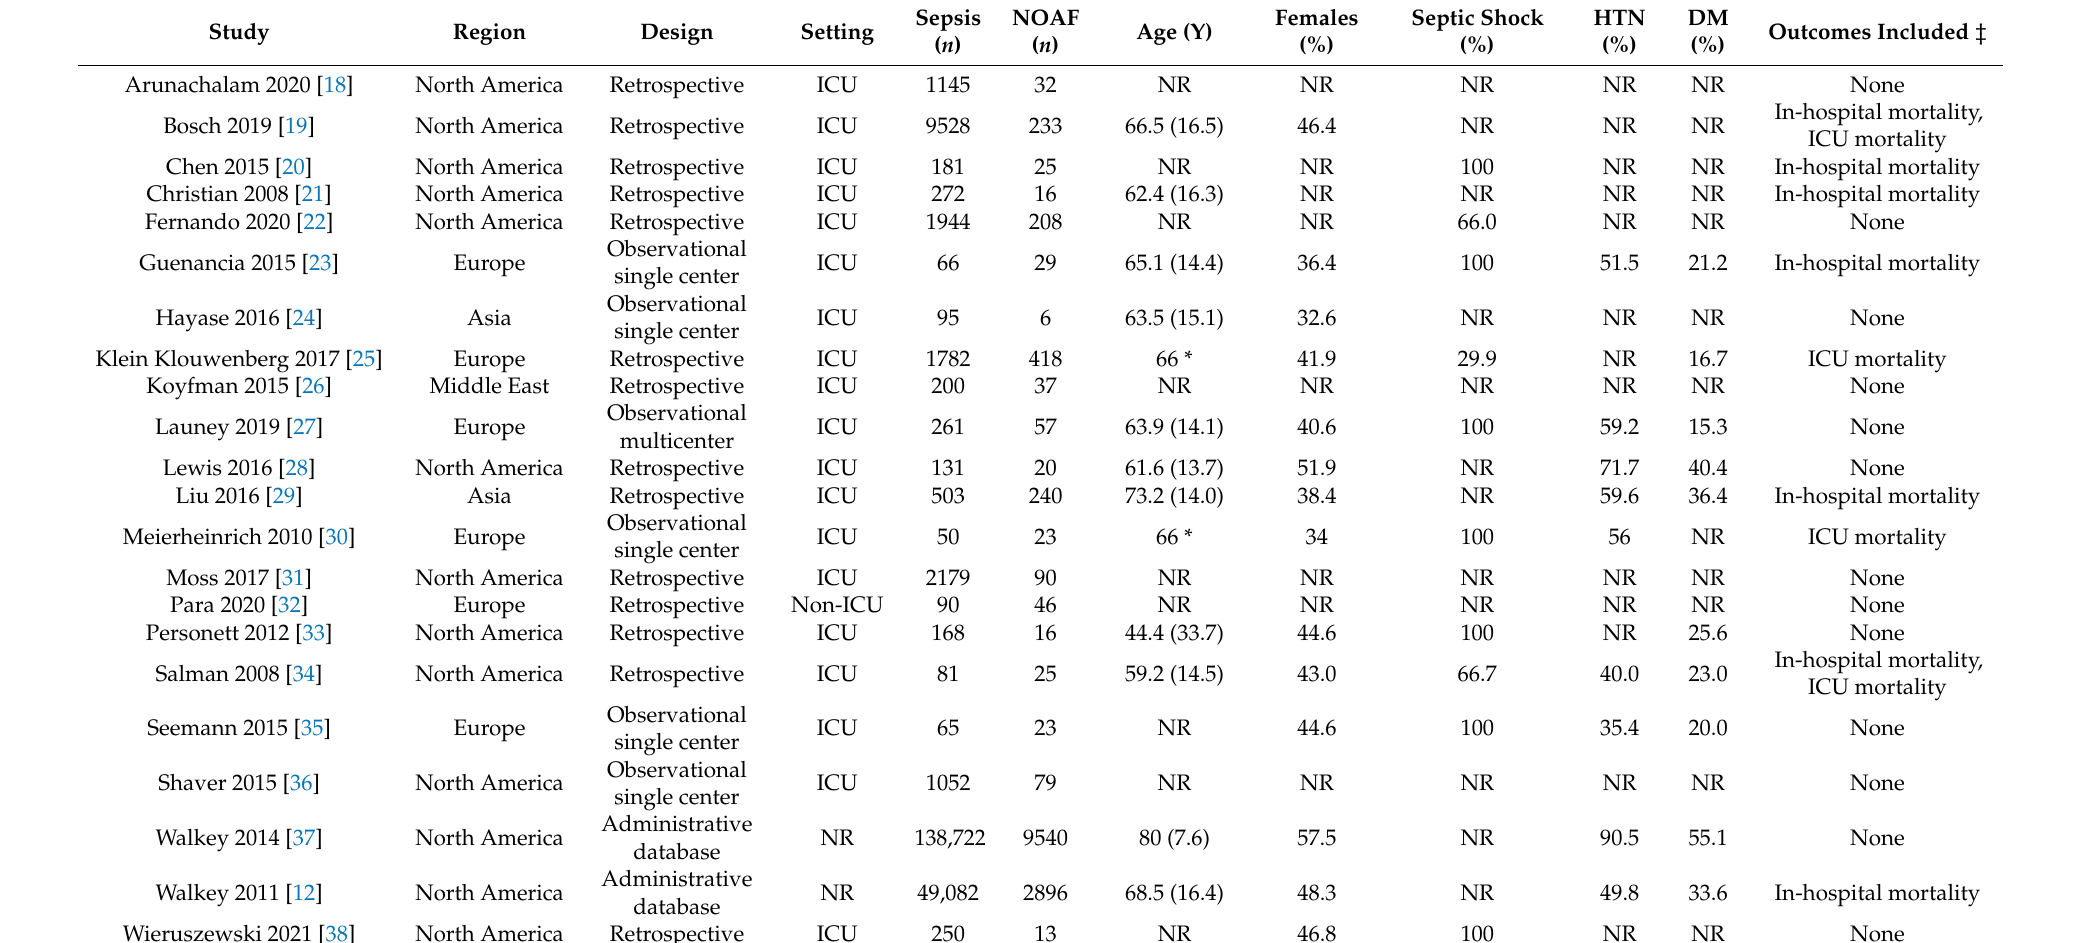
Table 1. Characteristics of the studies included in the systematic